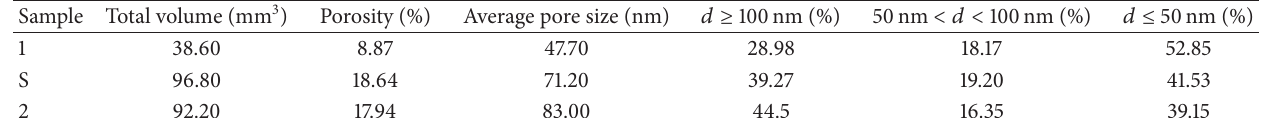
Table 6: Pore structure of concrete cores.